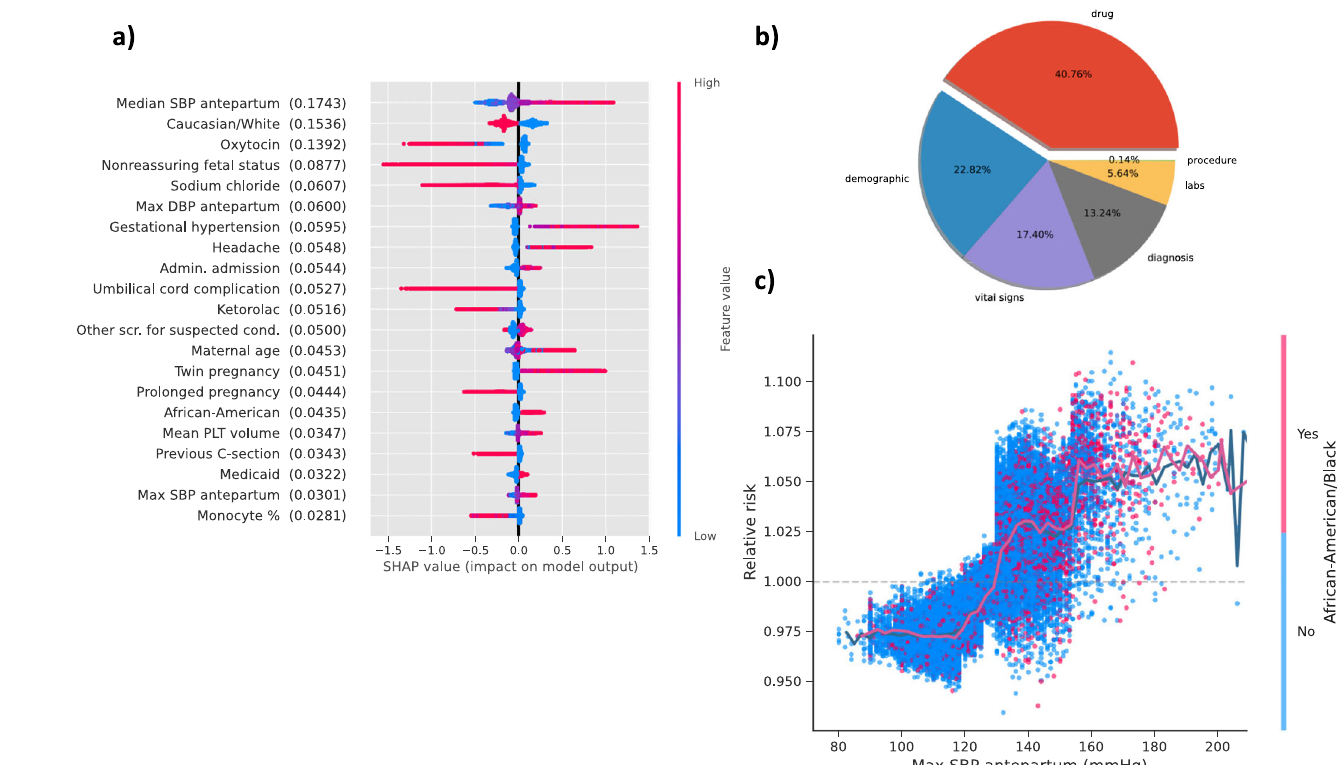
Fig. 5 Feature inspection for intrapartum based on SHAP value. a SHAP summary plot for top 20 clinical features for PE prediction shows the SHAP values for the most important features from gradient boosting model in the training data. Features in the summary plot ( Y -axis) are ordered by the mean absolute SHAP values (in the parenthesis after each feature name), which represents the importance of the feature in driving the intrapartum PE prediction. Values of the feature for each patient are colored by their relative value with red indicating high value and blue indicating low value. Positive SHAP values indicate increased risks for intrapartum PE and negative values indicate protective effects to intrapartum PE. b The average feature group contribution calculated from averaging mean absolute SHAP values for each feature set. c The dependence plot with maximum SBP measured in antepartum versus PE relative risk, along with the interaction of African American race. The plot shows how different values of the feature can affect relative risks and ultimately impact classi fi er decision. Data points are colored by the African American race. The solid line represents the mean of SHAP